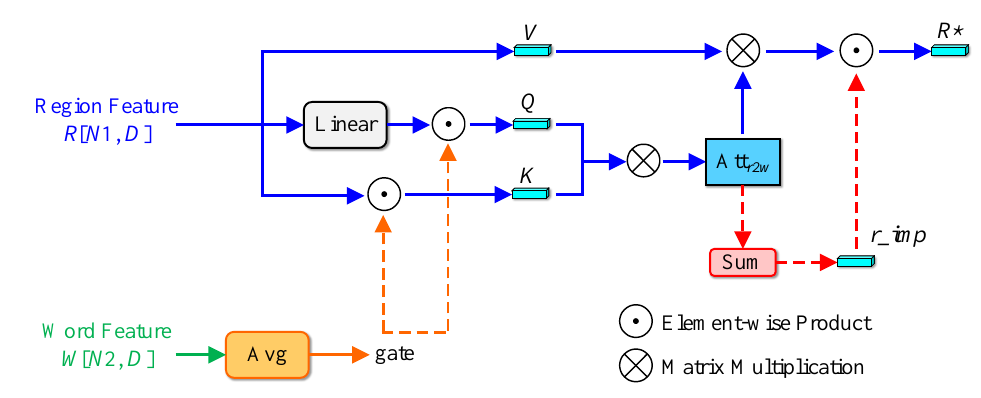
Figure 3. The self-attention (SA) block used in PAM for regions, with the conditioning gate (orange marked) and importance rectification (red marked). Similarly, an SA for words and Att w2w